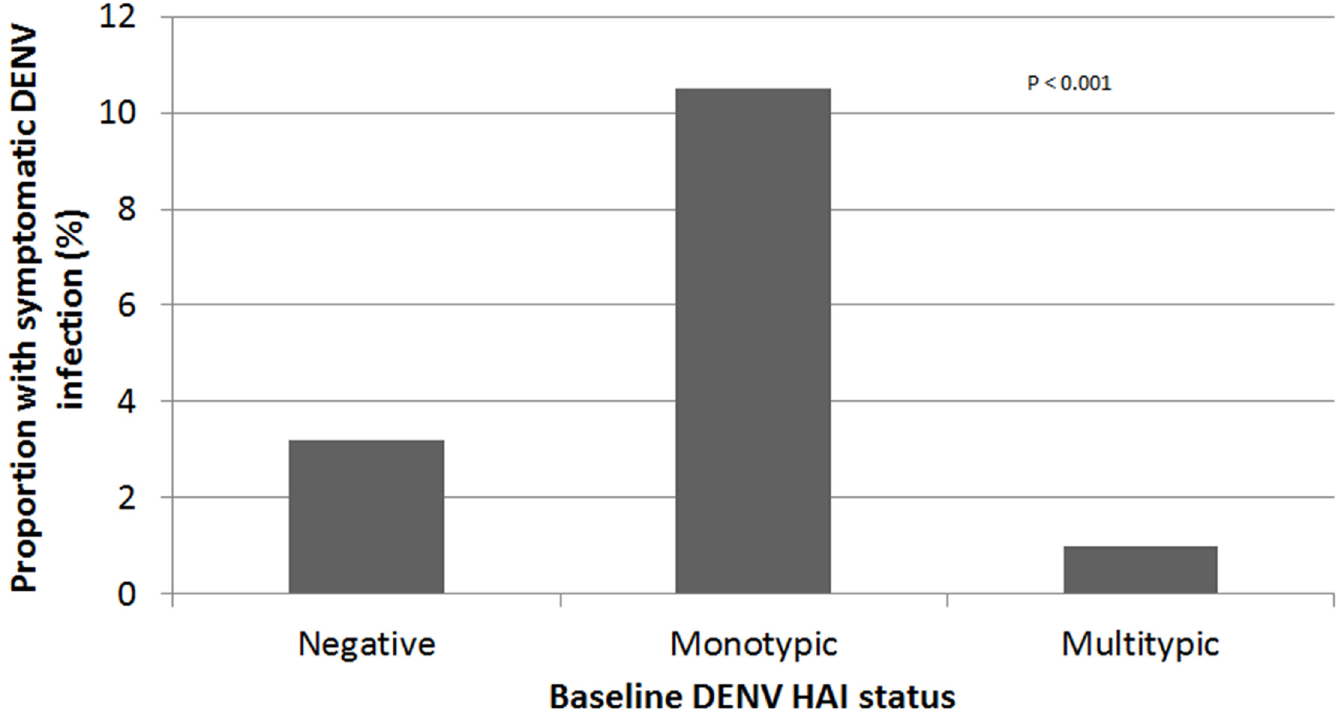
Fig 3. Proportion of symptomatic dengue virus (DENV) infections among all per-protocol subjects with different DENV hemagglutination inhibition (HAI) profiles at enrolment. Negative HAI: 4/125; monotypic HAI: 2/19; multitypic HAI: 7/710 (chi-square, p < 0.001). Three symptomatic cases in non-per- protocol subjects were not included because HAI testing was not